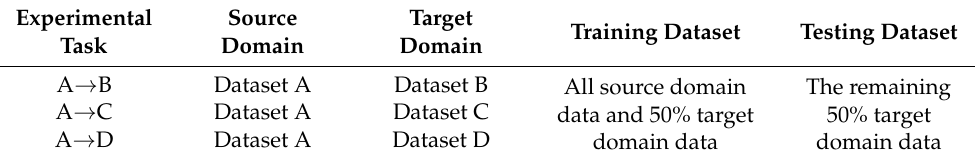
Table 2. Transfer diagnosis experiment in the diagnosis case